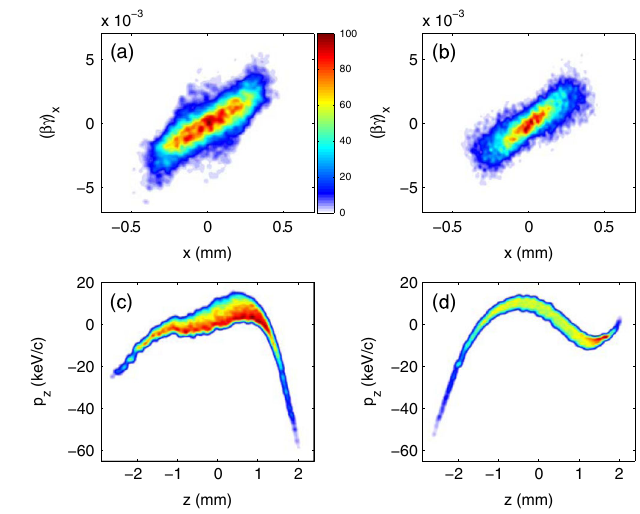
FIG. 12. Examples of the final phase space for 80 pC bunches ( MTE ¼ 0 : 12 eV ) for dc [(a),(c)] and SRF [(b),(d)]